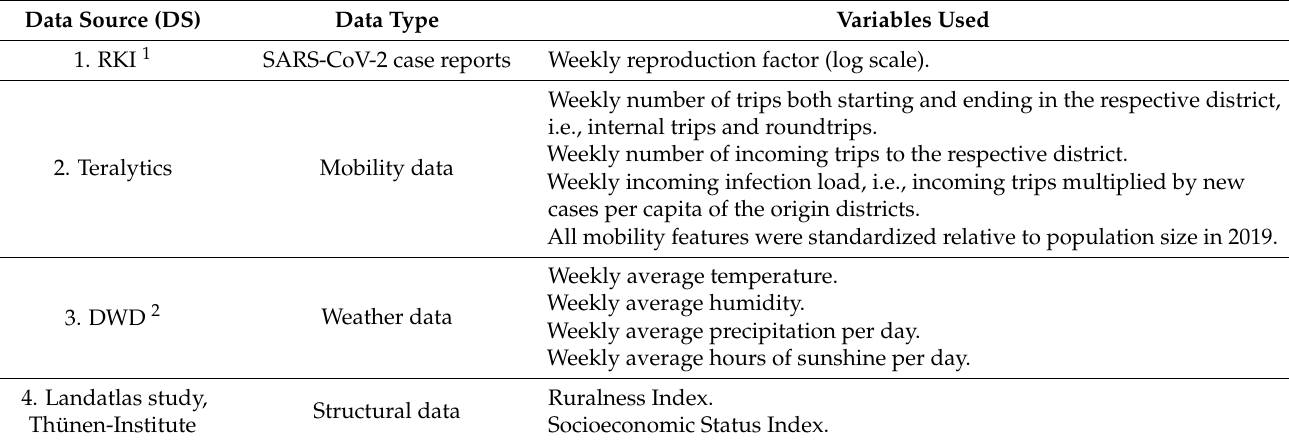
Table 1. Summary of the data